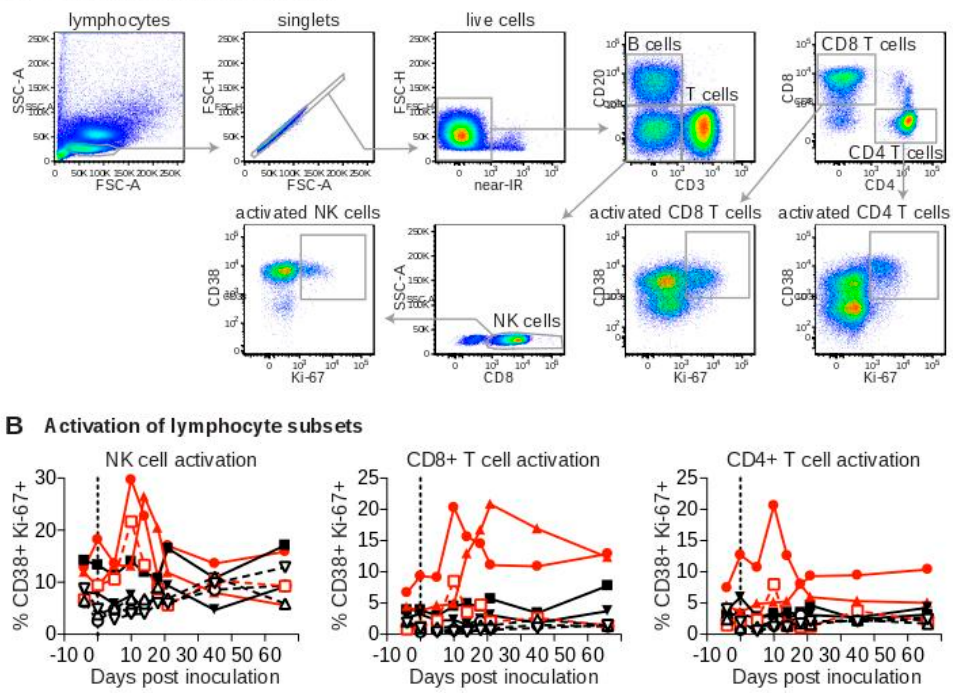
Figure 4. Flow cytometric analysis of peripheral blood lymphocytes from baboons and macaques inoculated with SWBV. Flow cytometry was performed on peripheral blood mononuclear cells (PBMC) that were purified and cryopreserved at the time of collection. Lymphocytes were phenotyped according to cell-surface markers, and co-expression of CD38 and Ki-67 was used as a marker of cellular activation. ( A ) Shows a representative sample at a single time-point with the gating strategy; ( B ) shows flow cytometry data from each animal over the course of the experiment. Macaques are shown as solid symbols with solid lines, baboons are shown as open symbols with dashed lines; infected animals are shown in red and uninfected animals are shown in black.